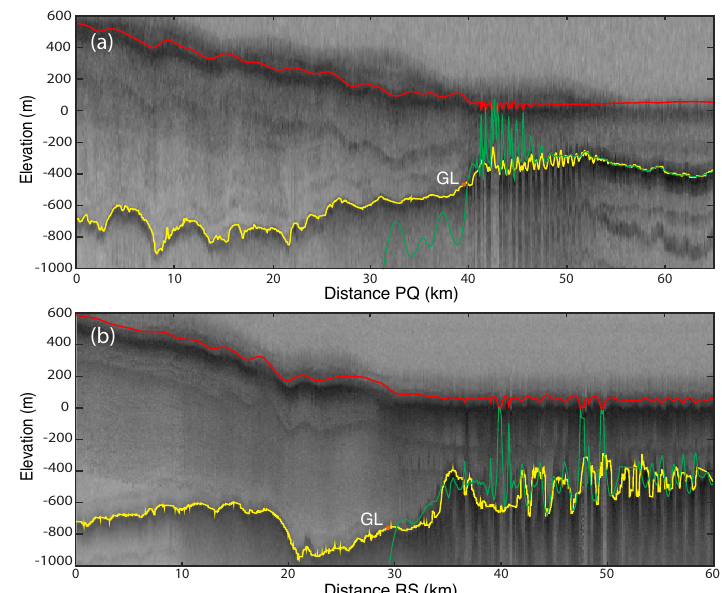
Figure 2. Two echograms of Thwaites Glacier (TG). (a) Echogram of flight track PQ on 2 November 2009. (b) Echogram of flight track RS on 19 November 2010. The red lines are ice surface elevation measured by Airborne Topographic Mapper (ATM) (Krabill, 2014) and the green lines are bed elevation calculated from hydrostatic equilibrium. The yellow lines are the elevation of ice bottom measured by ice radar depth sounder (Gogineni, 2012). The orange dots are the grounding line positions in 2011 (Rignot et al., 2011a).